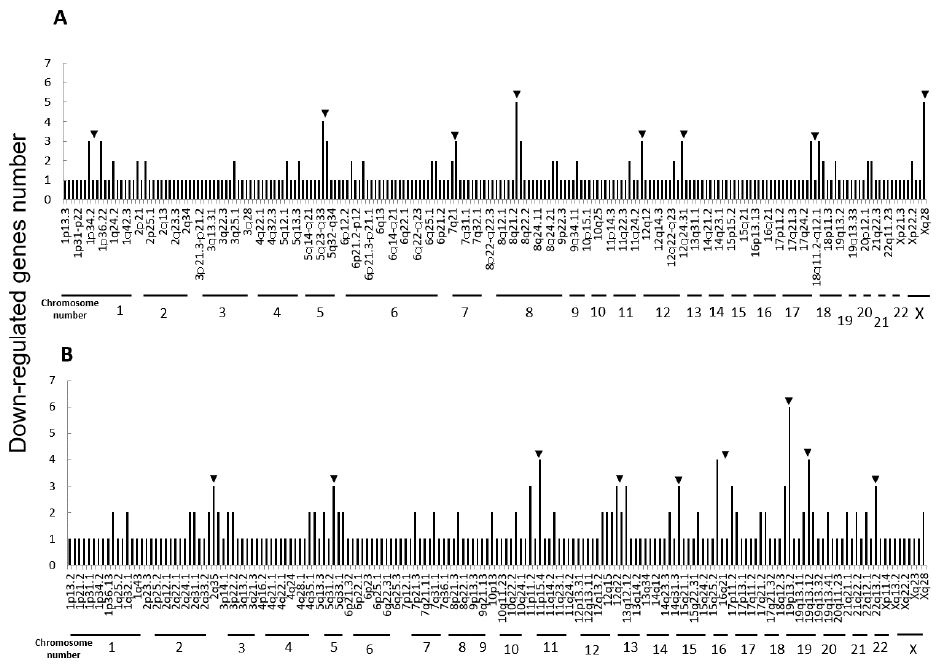
Figure 3. Chromosomal location of down-regulated genes in IR cells from microarray data. ( A ) The human non-small cell lung cancer cell line H1299. ( B ) The human breast cancer cell line MCF7. The arrowheads represent chromosomal locations where three or more differentially expressed genes are present.